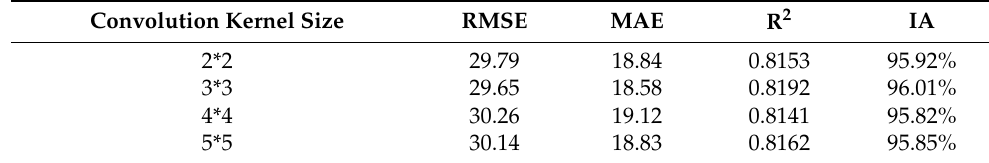
Table 3. Effect of convolution kernel size on experimental results in CBAM-CNN-Bi LSTM. (RMSE is the root mean squared error, MAE is the mean squared error, R 2 is the r- squared, IA is the index of